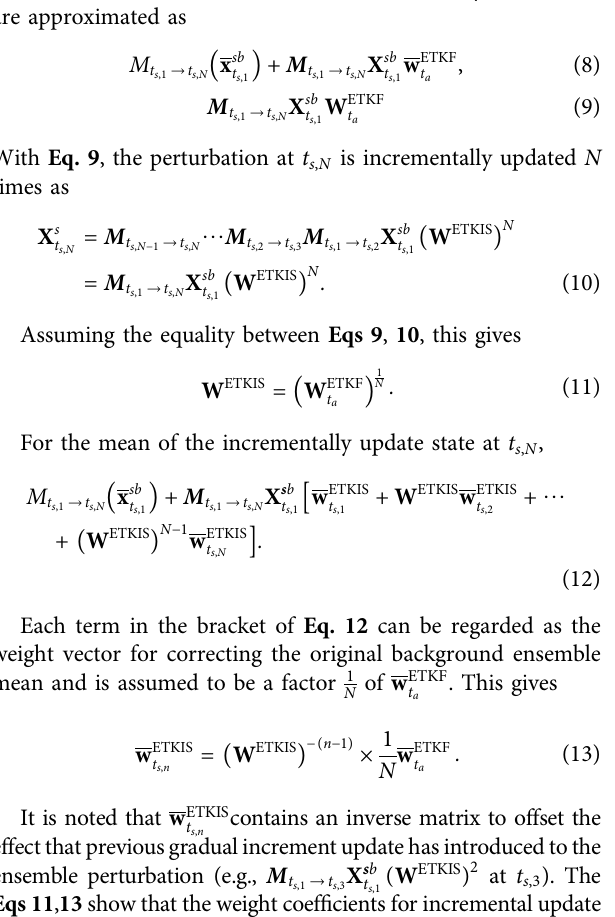
Frontiers in Applied Mathematics and Statistics |